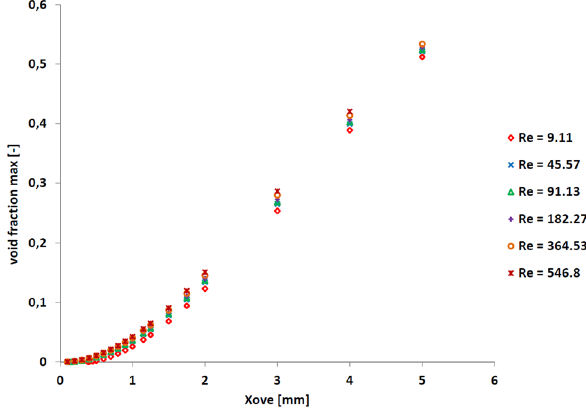
Fig. 8 Maximum void fraction according to X Fig. 6 Time evolution of the void fraction for H = 12 µm, of Reynolds number, H gap Ω = 700 rpm, p = 10 bar and X = 2 and 5 mm ( Re = 63.8 , pump ove We = 0.06 and 𝜎 = 6622.91 )